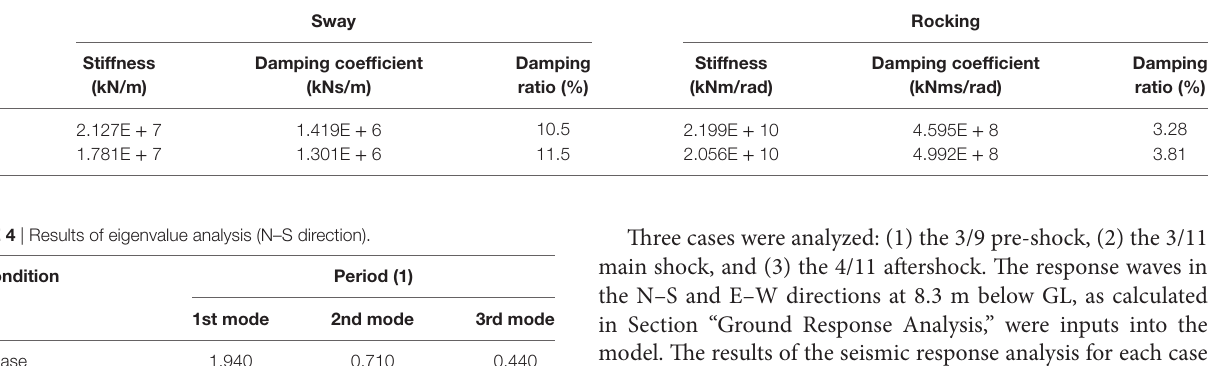
TaBle 3 | Soil properties used for response analysis.